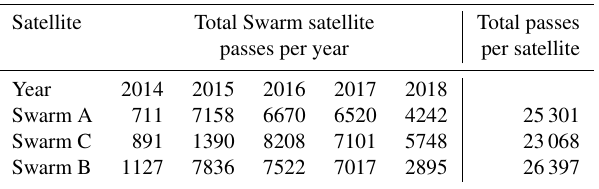
Table 1. Summary of yearly total Swarm satellite passes over the low-latitude region for which 16Hz data were